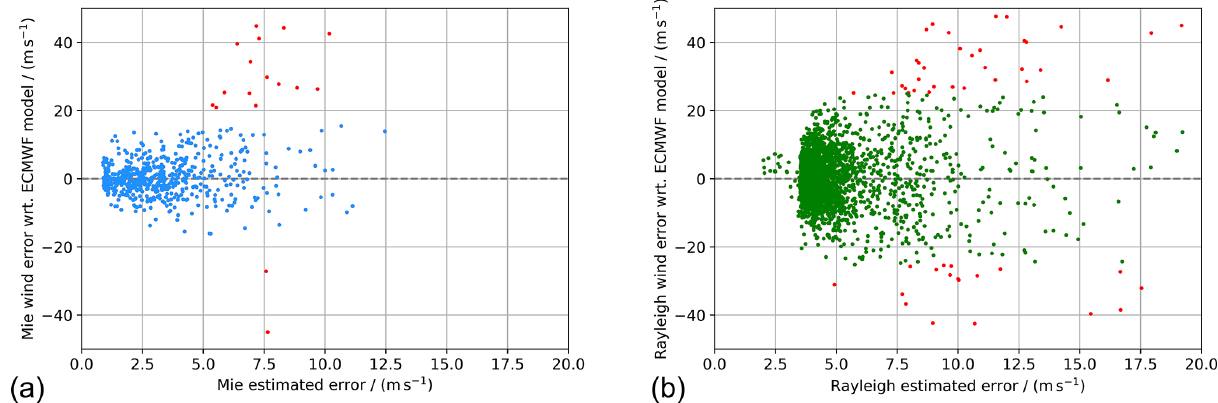
Figure 3. L2B Mie-cloudy (a) and Rayleigh-clear (b) wind error with respect to the ECMWF model background winds vs. the L2B EE for the 11 underflights of the AVATAR-T campaign. The red data points represent outliers, as identified by the modified Z score ( | Z m | > 3 . 5). Note that there are many more Mie outliers with errors greater than ± 50ms − 1 .